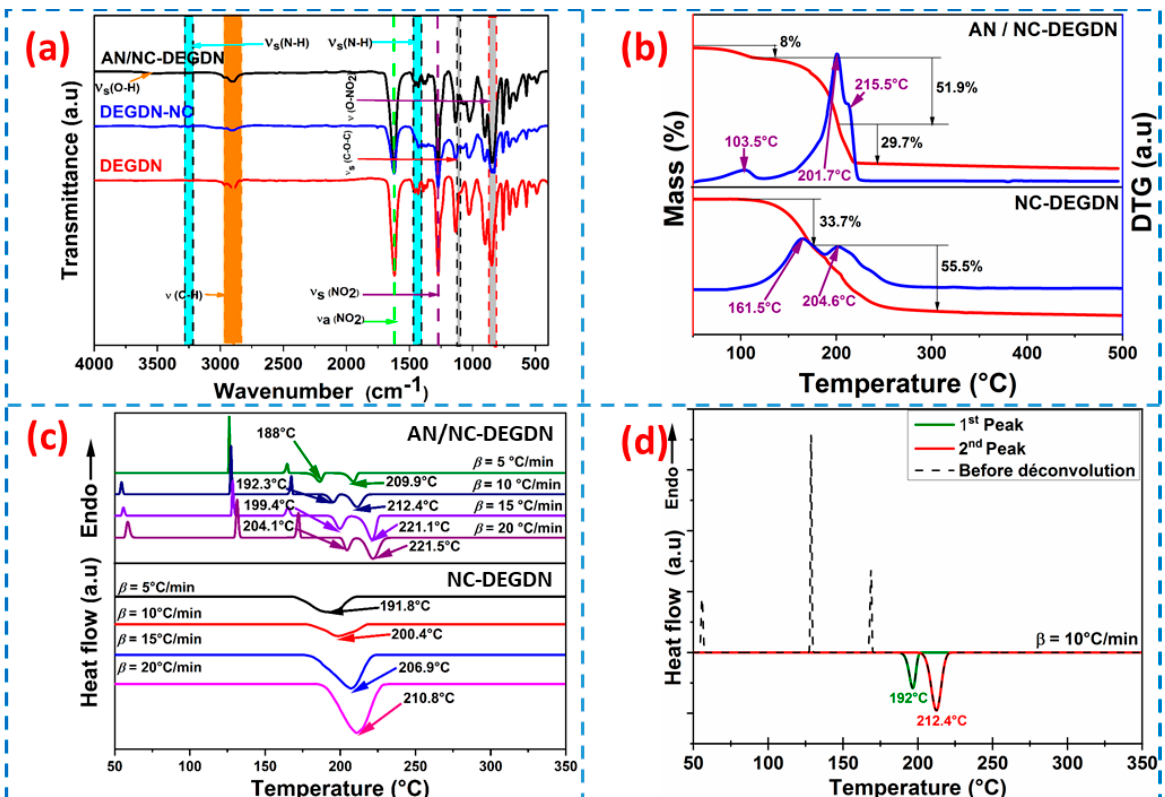
Figure 3. ( a ) FTIR spectra of DEGDN, NC/DEGDN, and AN/NC-DEGDN. ( b ) TG-DTG profiles of mixtures at 10 °C/min. ( c ) DSC thermograms of the different samples at different heating rates of 5, 10, 15 and 20 °C/min. ( d ) Mathematical deconvolution of the DSC thermogram of AN/NC-DEGDN formulation at β = 10 °C/min.